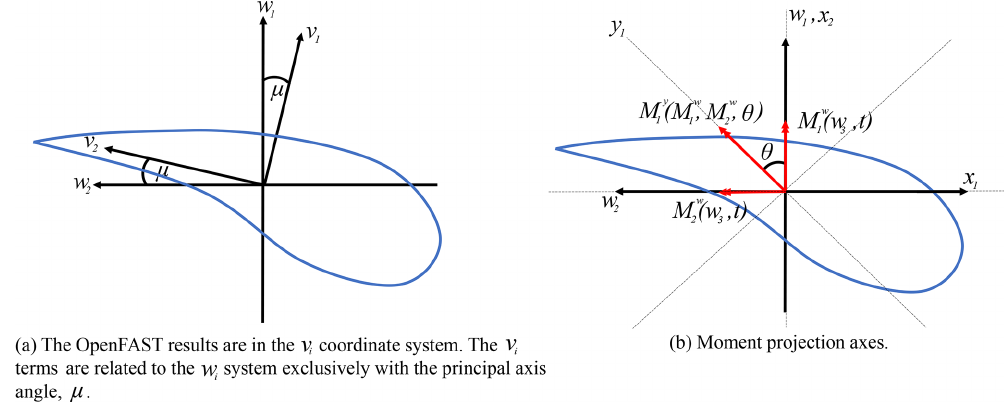
Figure 3. Coordinate systems used to transfer time histories from OpenFAST to the ANSYS